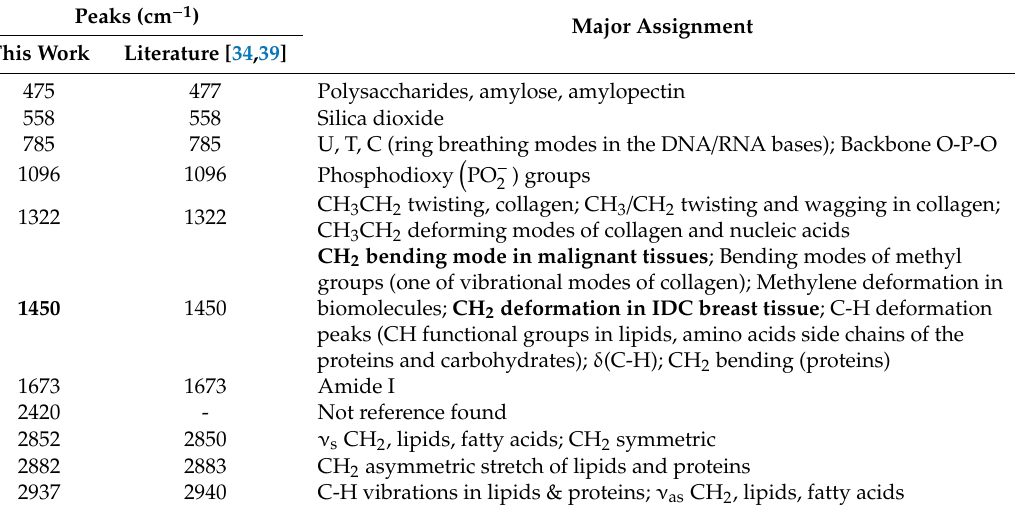
Figure 6. Raman spectra of demineralized areas of the mixed carcinoma (sample #3) and, on the right side, the corresponding microscopic image (50 × , Raman spectrometer system). The inset shows a microscopic image (2.5 × ) of demineralized areas stained by means of Von Kossa-Van Gieson modified method. Table 8. Peak position and assignment of demineralized areas of the mixed carcinoma (sample #3). Peaks (cm − 1